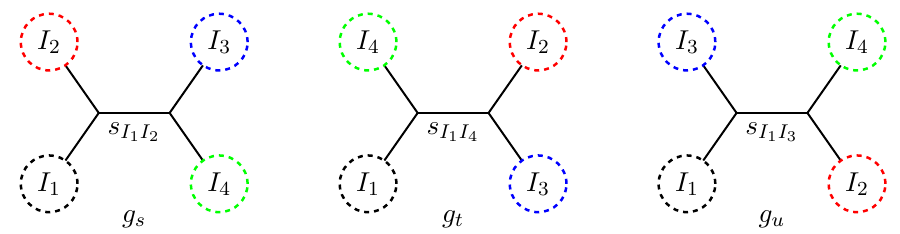
Figure 1 : A triplet of three cubic tree graphs that differ by one